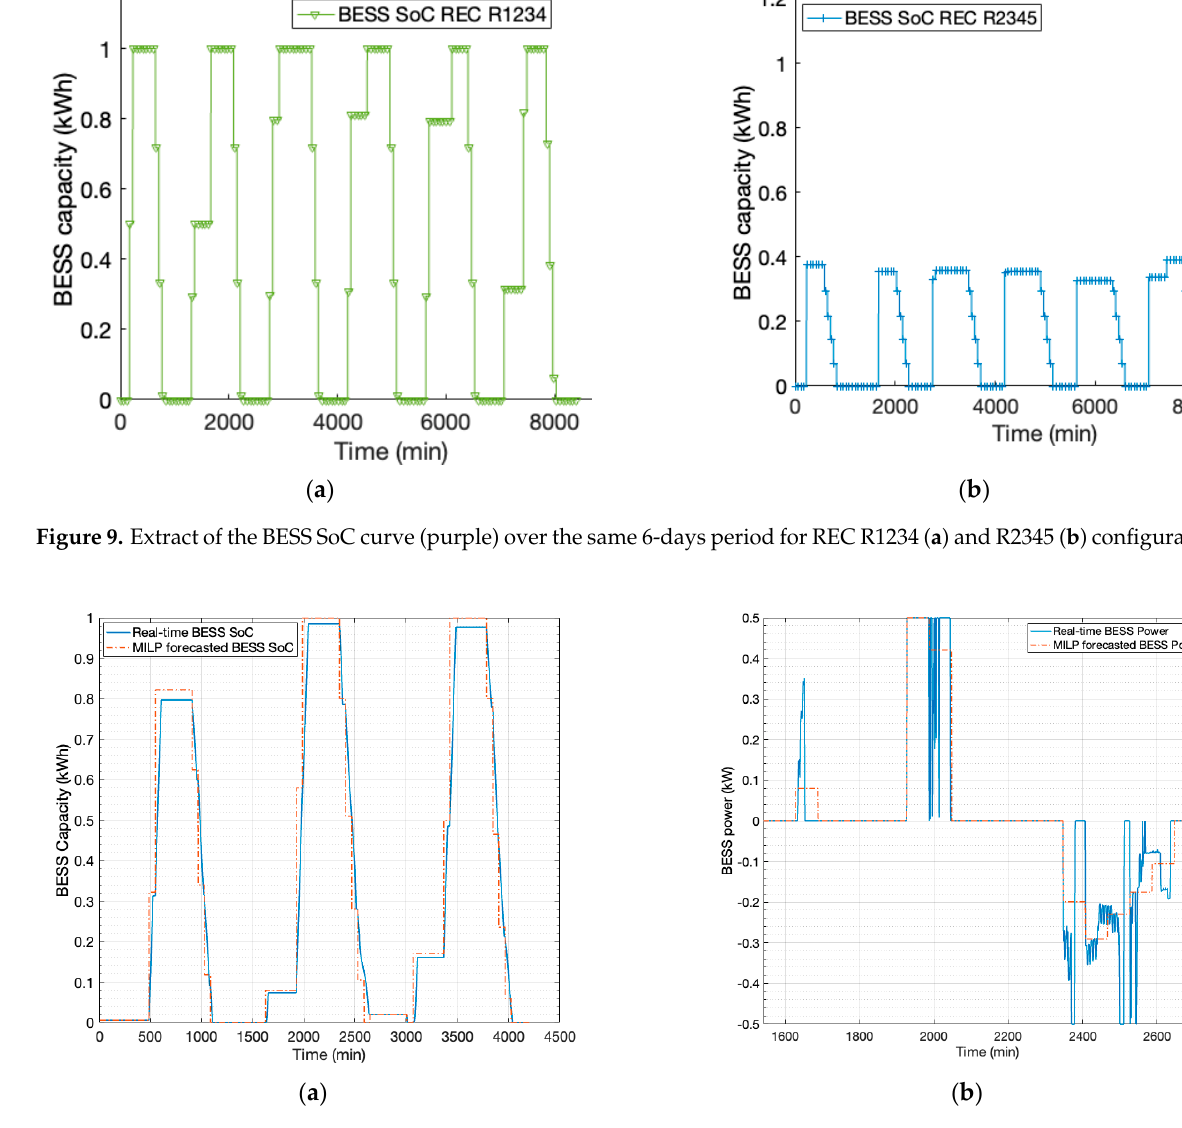
Figure 10. Three-days extract from real-time BESS management outcomes showing a comparison between real-time operation (light blue) and MILP scheduled setpoints (red) for BESS capacity and usage ( a ). Comparison between MILP scheduling for average BESS power exchange over hourly time periods (red) and corresponding real-time BESS power exchanges (light blue) ( b